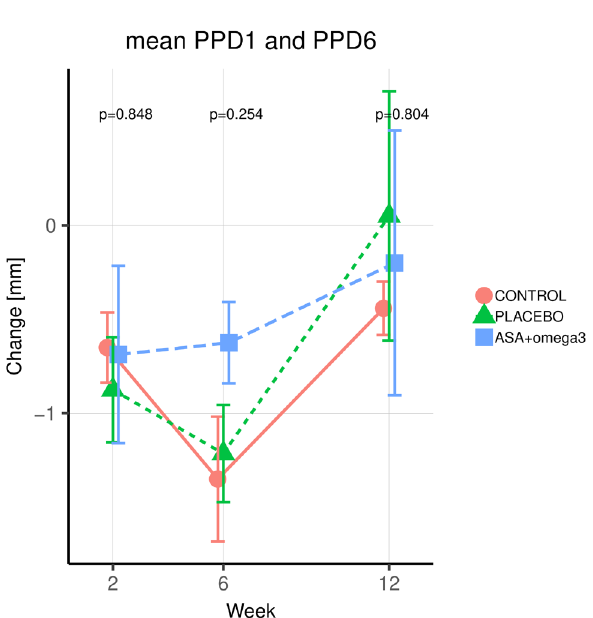
Fig. 3. Probing pocket depth. Difference between baseline measurements (Day 0) of PPD at locations 1 and 6 and PPD measured at 2 weeks, 6 weeks, or 12 weeks.